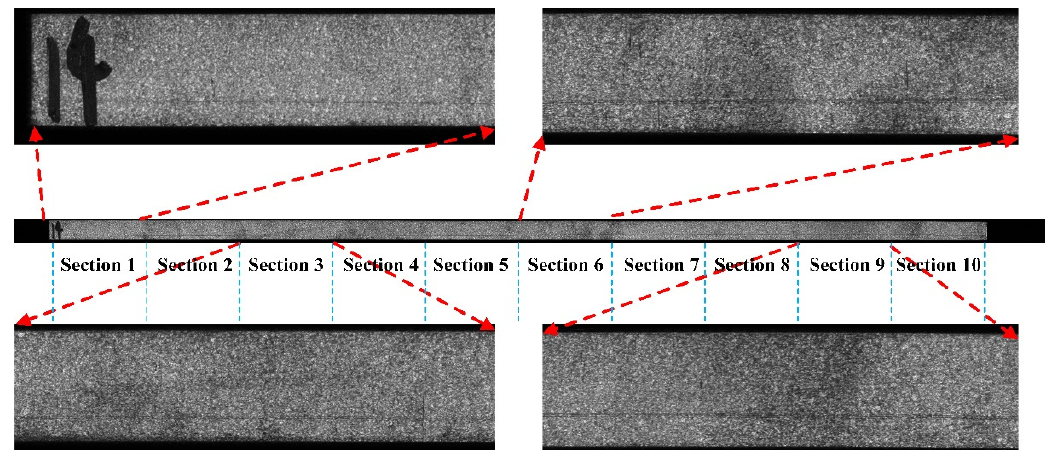
Figure 3. Segmentation of the Input Image.